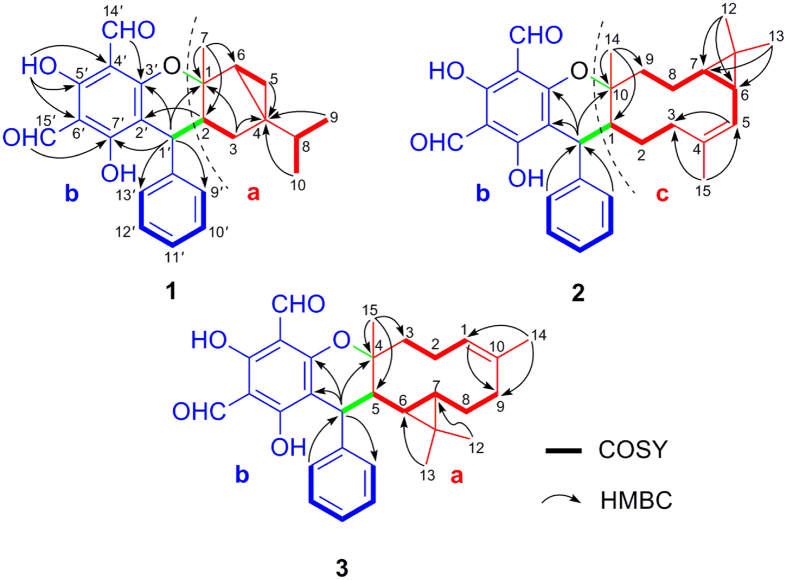
Key 1H–1H COSY and HMBC correlations of 1–3.